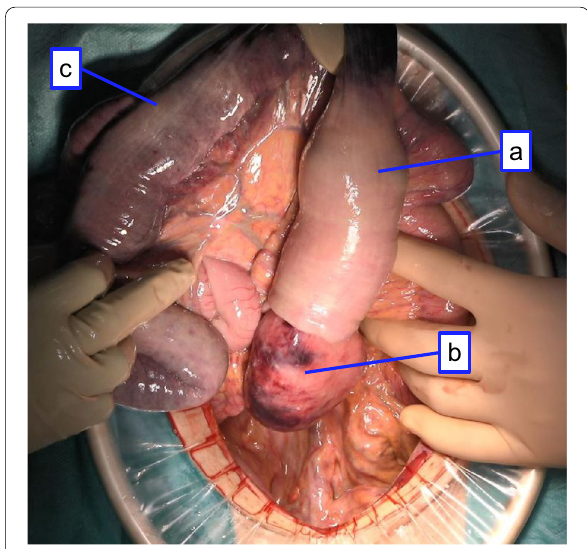
Fig. 2 Intraoperative findings. a A jejunal tumor telescoped inside of the oral jejunum which caused intussusception. b The jejunum had necrotic or ischemic change. c The transverse colon had necrotic or ischemic change